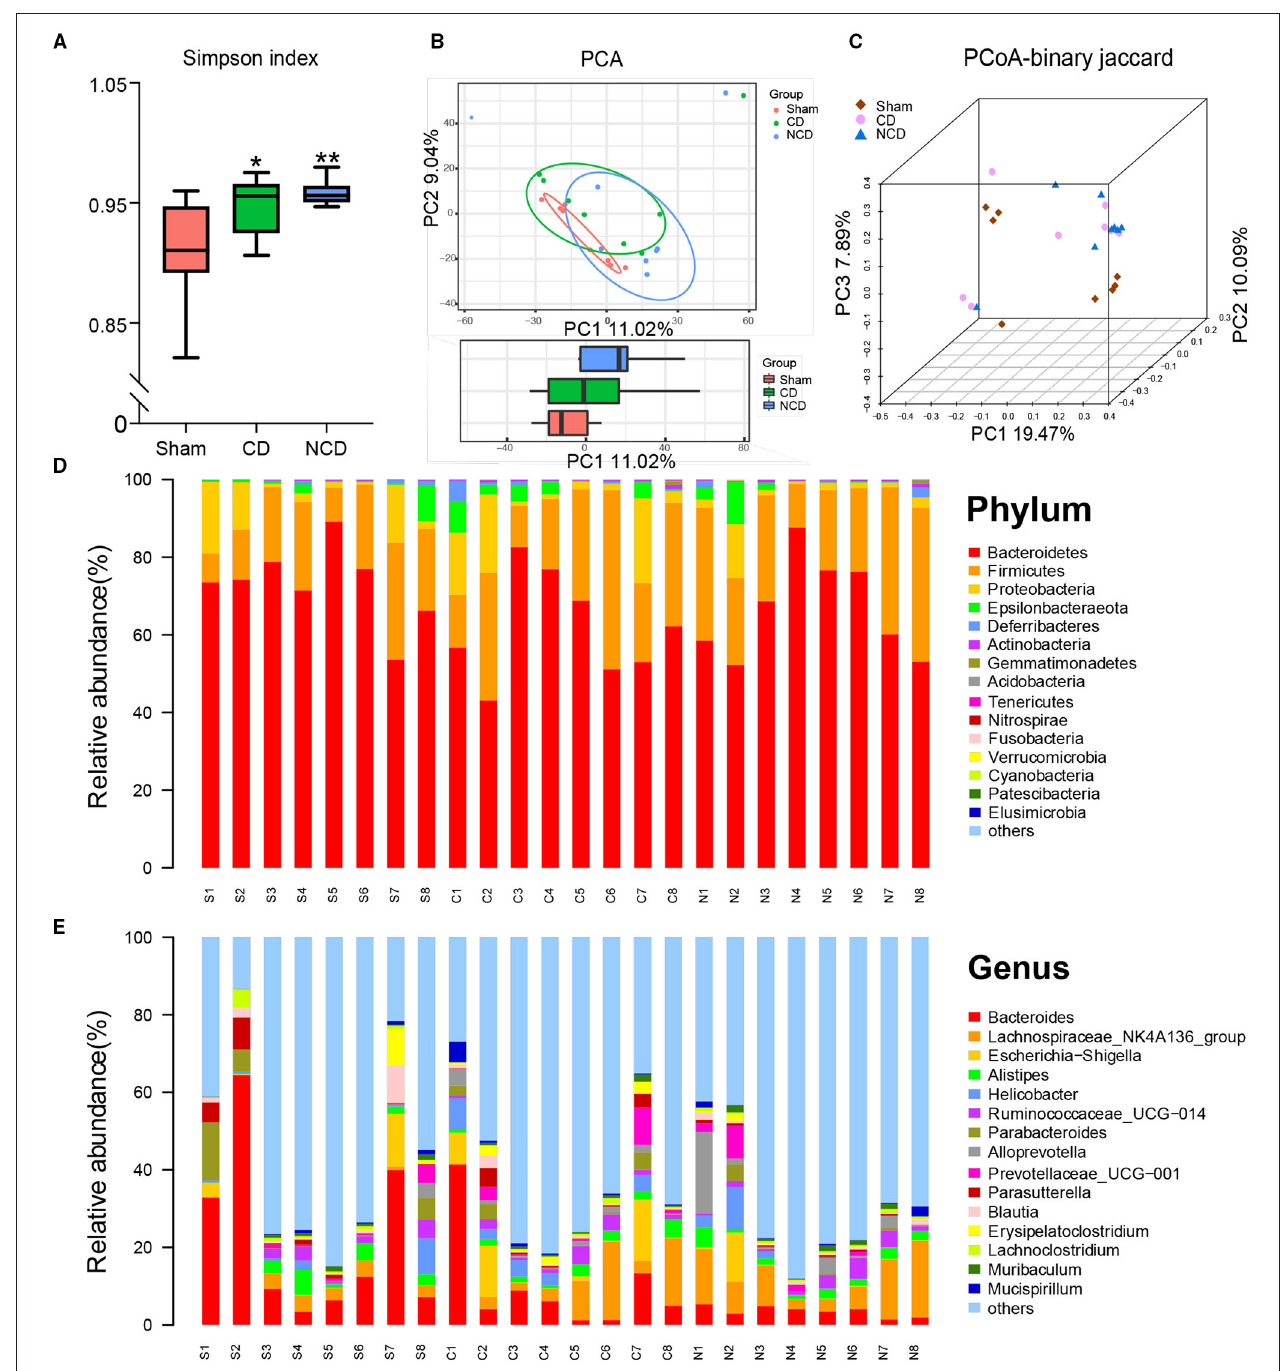
FIGURE 2 | Differential profiles of gut microbiota among Sham, CD, and NCD groups. (A) Simpson index [ F (2, 21) = 6.557, P = 0.006]. (B) The PCA of gut microbiota (PC1 vs. PC2). (C) PCoA-binary Jaccard dissimilarity. (D) The top 15 abundant flora among the groups at the phylum level. (E) The top 15 abundant flora among the groups at the genus level. Data are presented as means ± SEM ( n = 8 per group) and analyzed by one-way ANOVA followed by Tukey’s post hoc test. * P < 0.05, ** P < 0.01. CD, cognitive dysfunction; NCD, non-cognitive dysfunction; N.S., not significant.